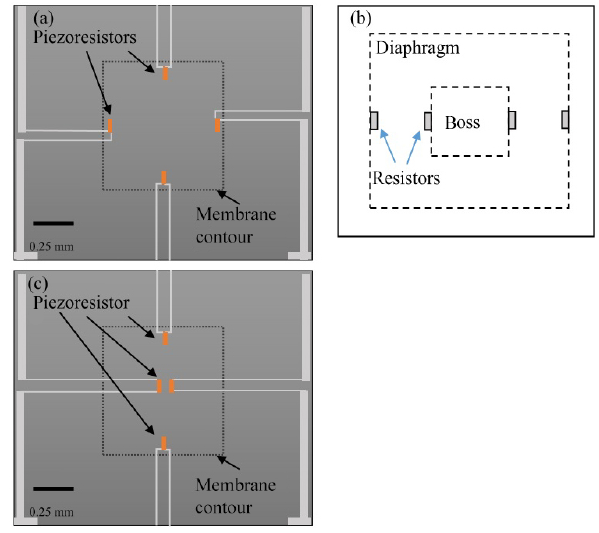
Figure 2. Resistor placement on diaphragm-based piezoresistive pressure sensors: (a) four resistors placed on the diaphragm edges and (b) two resistors on the diaphragm edges and the other two at the centre of the diaphragm. In both cases, the resistors are con- nected in Wheatstone bridge (c) resistors mounted on the inner and outer perimeters on a bossed diaphragm (Beeby et al., 2004; Chien- Hung et al.,